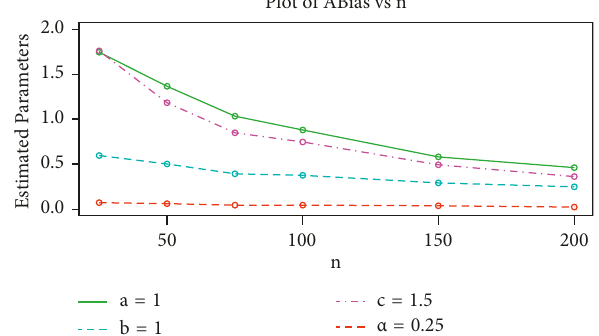
Figure 5: The plots of ABs for the ExEW parameters in set III.